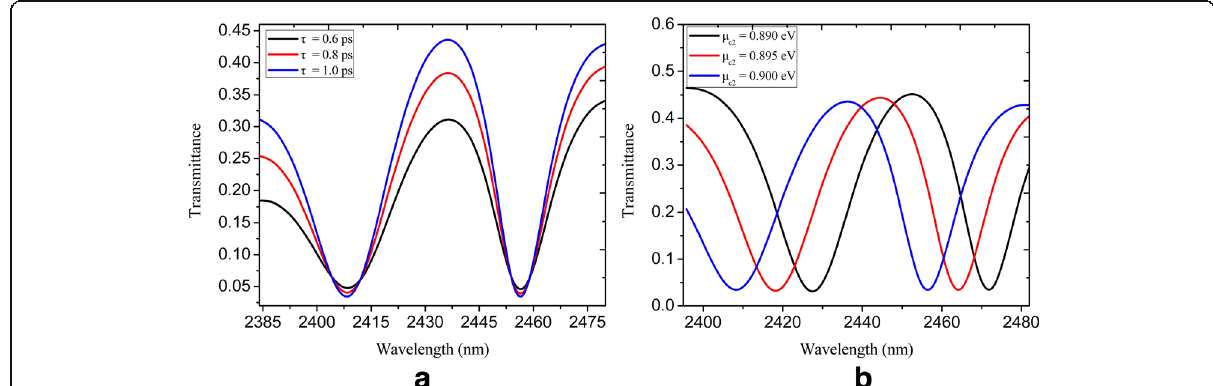
Fig. 4 The spectral transmittance of U-shaped and rectangular nanocavity-coupled waveguide system shown in Fig. 3: a with τ = 0.6, 0.8, and 1 ps; b with μ c2 = 0.89, 0.895, and 0.9 eV